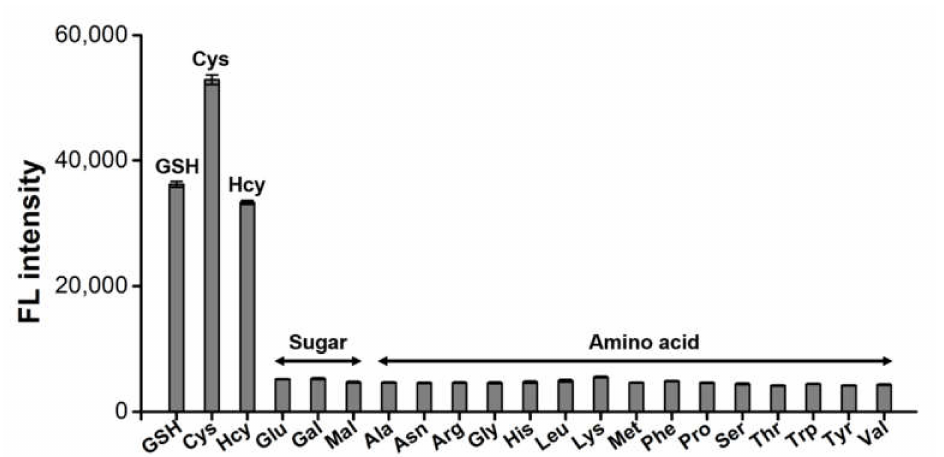
Figure 3. Selectivity of HRP-Cu NFs-based biothiol detection system. 1 µ M biothiols (GSH, Cys, and Hcy) as well as 20 µ M of other carbohydrates and amino acids were used.